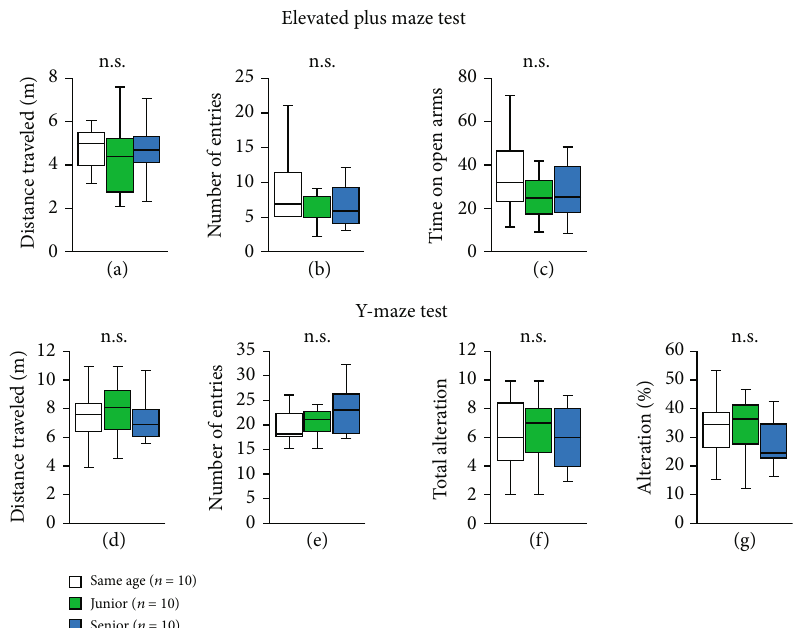
Figure 2: E ff ect of group housing condition on performance on the elevated plus maze and Y-maze tests. (a – c) Elevated plus maze test. Graphs showing the total distance traveled (a), the number of entries into the open arm (b), and the time spent in the open arms (c) in the elevated plus maze test. (d – g) Y-maze test. Graphs showing the total distance traveled (d), the total number of arm entries (e), the total number of alternations (f), and the percentage of alternations (g). All data are presented as box plots. ∗ Signi fi cant di ff erence in comparisons between groups ( p < 0 : 05 ). The p values were calculated using two-way (Figure 2(c), two-way ANOVA: F = 0 : 982 , p = 0 : 387 ; post 2 , 28